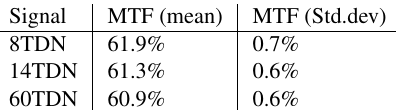
Table 1. Signal dependence (spatial direction, 495 nm ) at